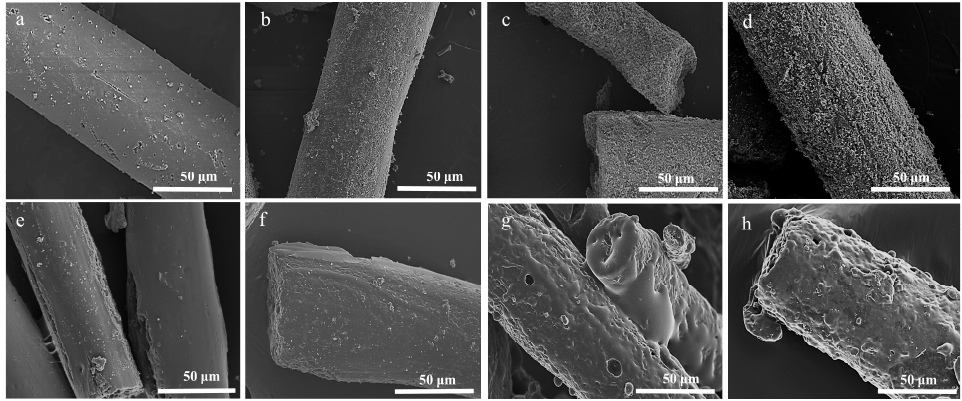
Figure 2. SEM images of ( a ) LSF-0, ( b ) LSF-0.2, ( c ) LSF-0.4, ( d ) LSF-0.6, ( e ) LCF-0, ( f ) LCF-0.2, ( g ) LCF-0.4, and ( h ) LCF-0.6.